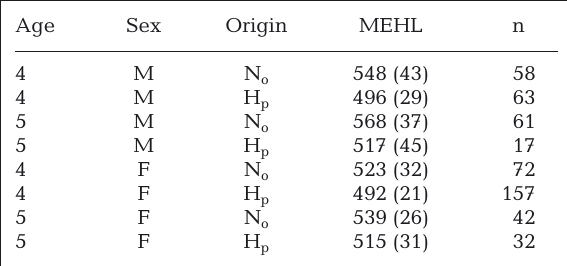
Table 3. Mean mid-eye to hypural length (MEHL, mm; with SD in parentheses) by age and sample sizes (n) for groups of hatchery-produced (H p ) and natural-origin (N o ) chum salmon of both sexes in dominant age classes